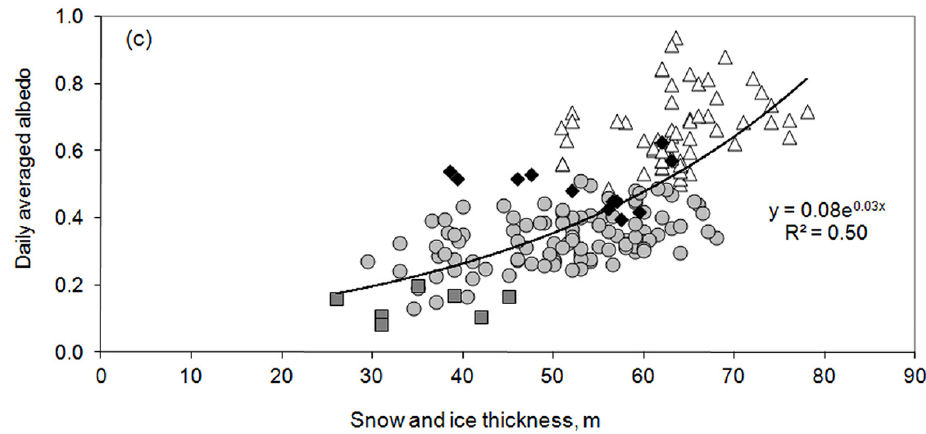
Figure 7. ( a )—surface daily averaged albedo of Lake Vendyurskoe from end of March to early May, ( b )—dependence of albedo on the accumulated sum of positive temperatures from March 1, and ( c ) —dependence of albedo on the thickness of the snow-ice cover for all years of measurements (1995–2000 and 2002–2017). Snow (triangles), white ice (circles), congelation ice (squares), snow spots on white ice (diamonds).